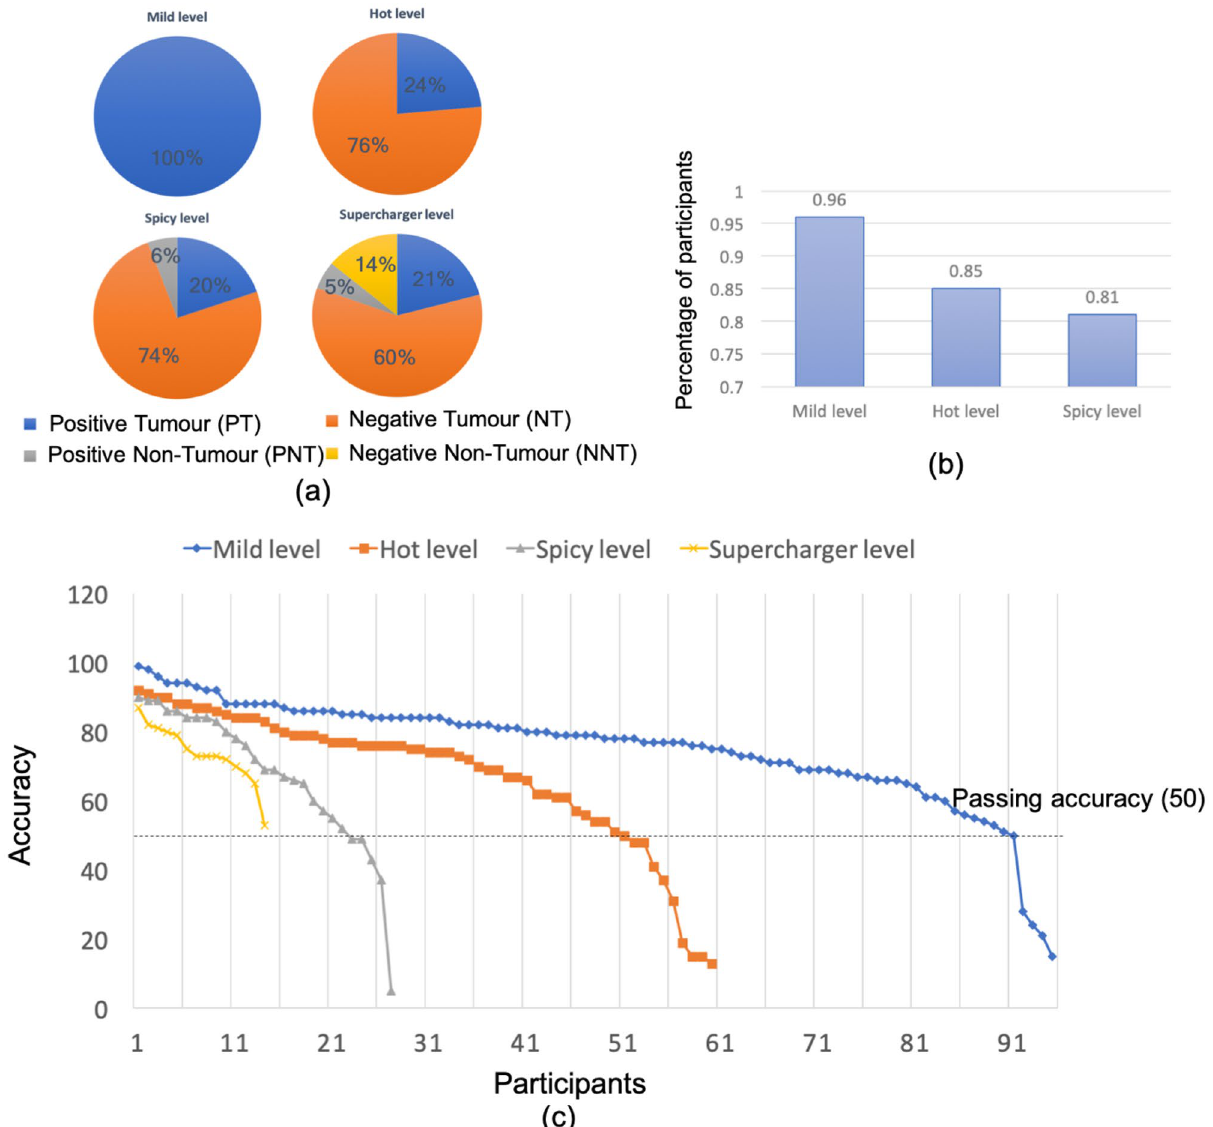
Figure 3. ( a ) Percentage of different kinds of cells in the four competition levels: Mild, Hot, Spicy and Supercharger. ( b ) Percentage of participants who pass the current level and join the next level. ( c ) Accuracy of all participants in the competition